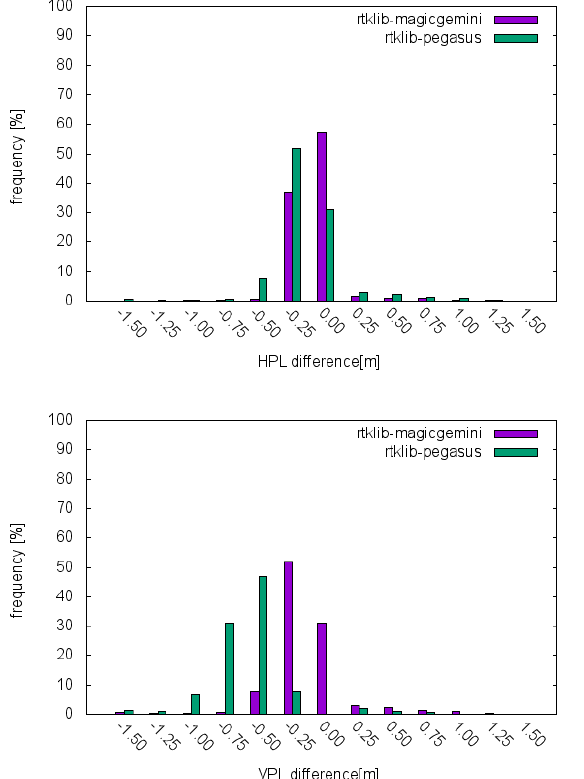
Figure 2. Histogram of differences of the horizontal and vertical protection levels calculated by RTKLIB,